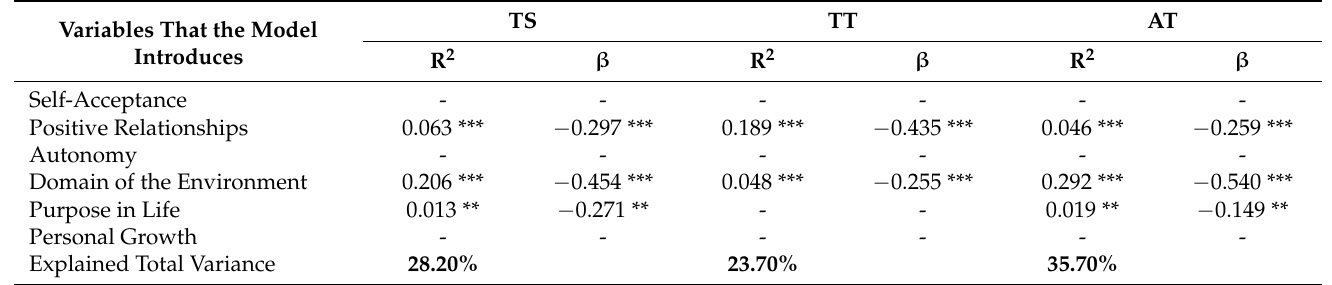
Table 5. Psychological well-being and emotional intelligence variables that influence the regulation of burnout in active teachers and teachers in